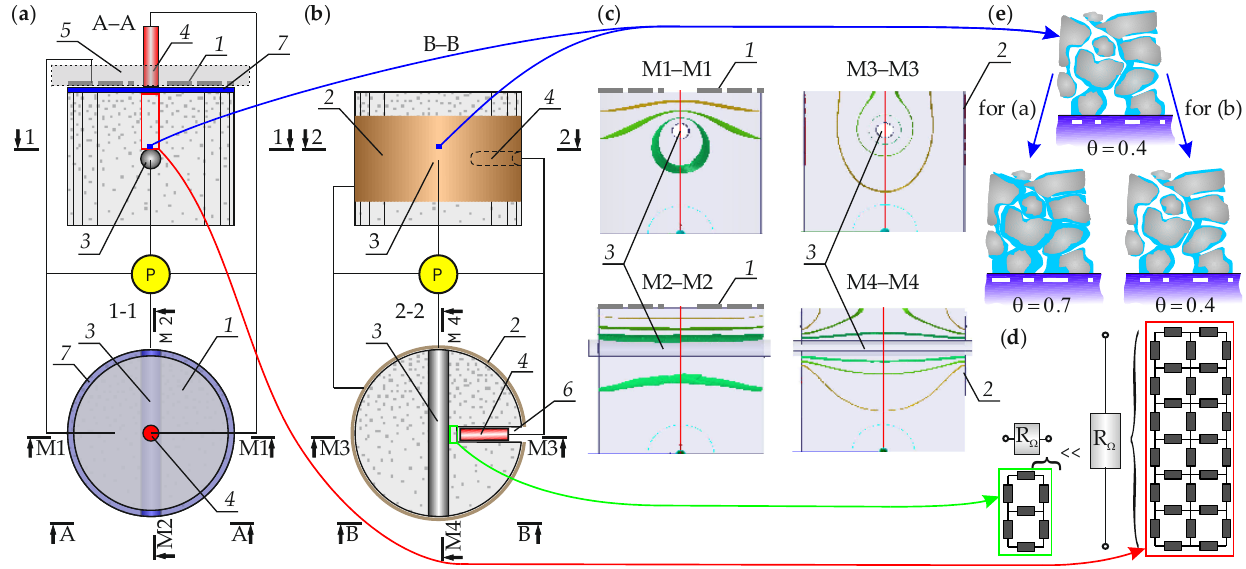
Figure 14. Benefits obtained from using solid reference and auxiliary electrodes for polarization measurements of concrete cores drilled from the structure: ( a ) drilled concrete cores with electrodes conventionally applied on the bottom; ( b ) drilled concrete core with electrodes placed in an opening or applied on the surface; ( c ) polarization distribution for the working electrode at the auxiliary electrode on the bottom and side surface, cf. [32]; ( d ) compared resistance of concrete layer between the reference and working electrode, with reference to cases ( a , b ); and ( e ) an impact of increased humidity in the cylindrical specimen on steel covering with pore solution, 1 — applied auxiliary electrode, 2 — solid auxiliary electrode, 3 — a rebar fragment used as the working electrode, 4 — reference electrode, 5 — measurement probe, 6 — an opening in the core concrete for the reference electrode, 7 — wet or damp spacer, 𝑅 Ω — resistance of concrete layer between the reference and the working electrode, — degree of steel covering with pore solution, P — potentiostat — description and notes in the text.